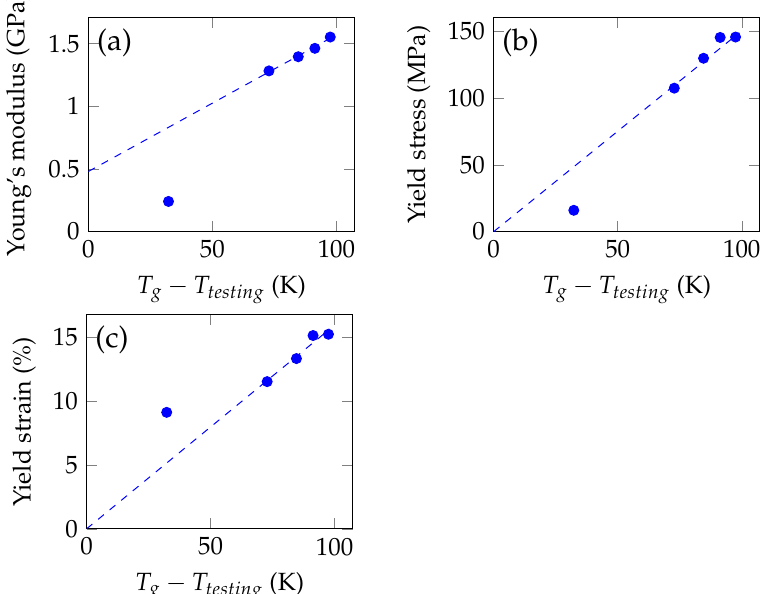
Figure 6. The results of the uniaxial compression testing were related to the difference of glass transition temperature and the testing temperature. M n of PPG is 446. ( a ) The dependence of the elasticity modulus on the relative glass transition temperature. ( b ) The dependence of the yield stress on the relative glass transition temperature. ( c ) The dependence of the yield strain on the relative glass transition temperature. The dependencies show linear relation between the mechanical properties and the relative glass transition temperature in the region of the moderate (up to 17%) fractions of the PPG units. Dependencies of yield stress and strain go through zero, unlike the elasticity modulus, which is expected, as at glass transition temperature the segmental mobility of macromolecules becomes